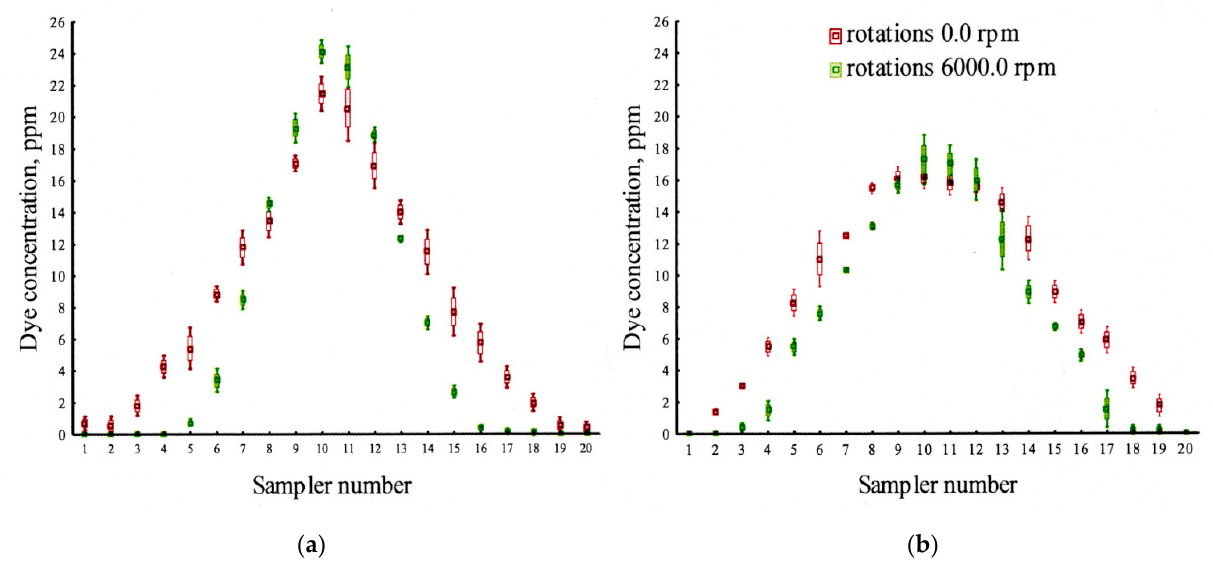
Figure 8. Impact of air flow from the drone propeller rotation on the transverse distribution of the liquid in the droplet stream: ( a ) Air-injector twin flat spray nozzle; ( b ) Air-injector flat spray nozzle.